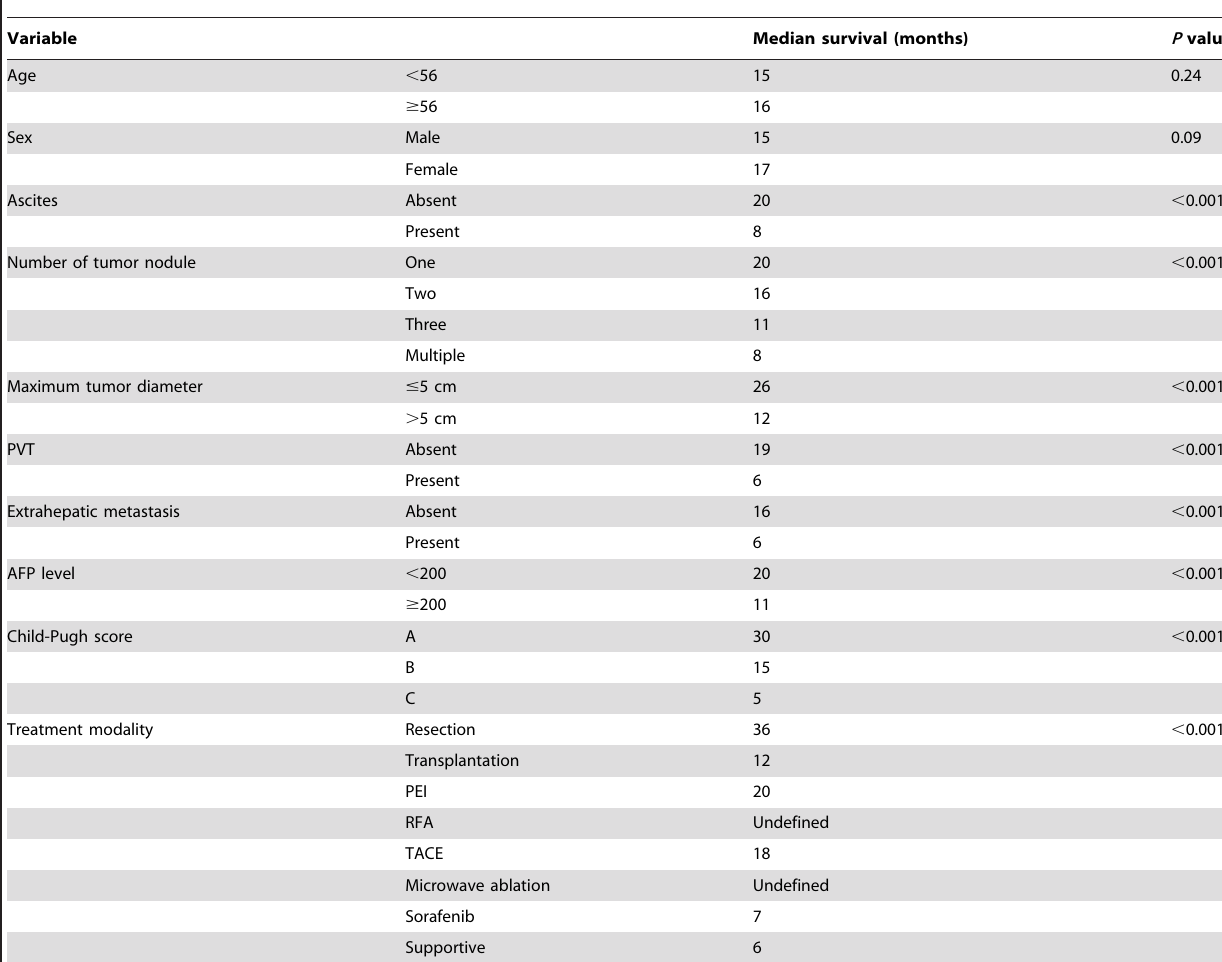
Table 3. Univariate analysis of baseline predictors of survival.